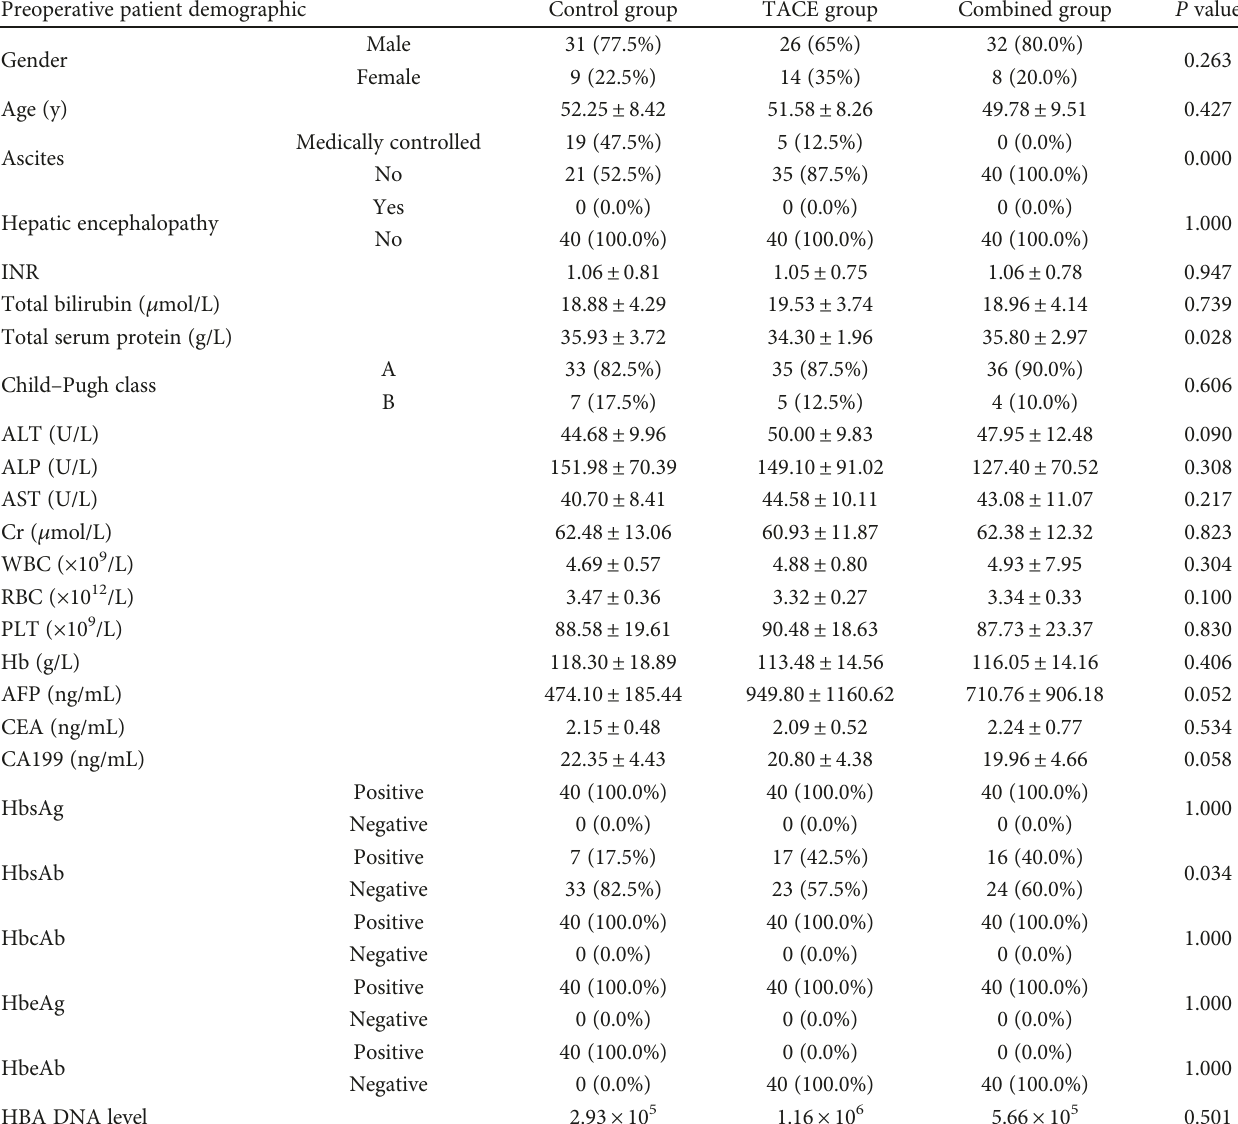
Table 1: Preoperative demographic characteristics of patients in the three